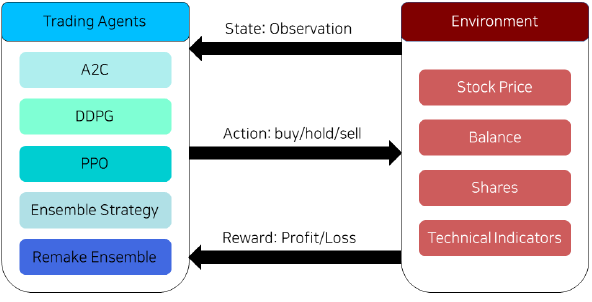
Figure 2. Stock Trading Mechanism